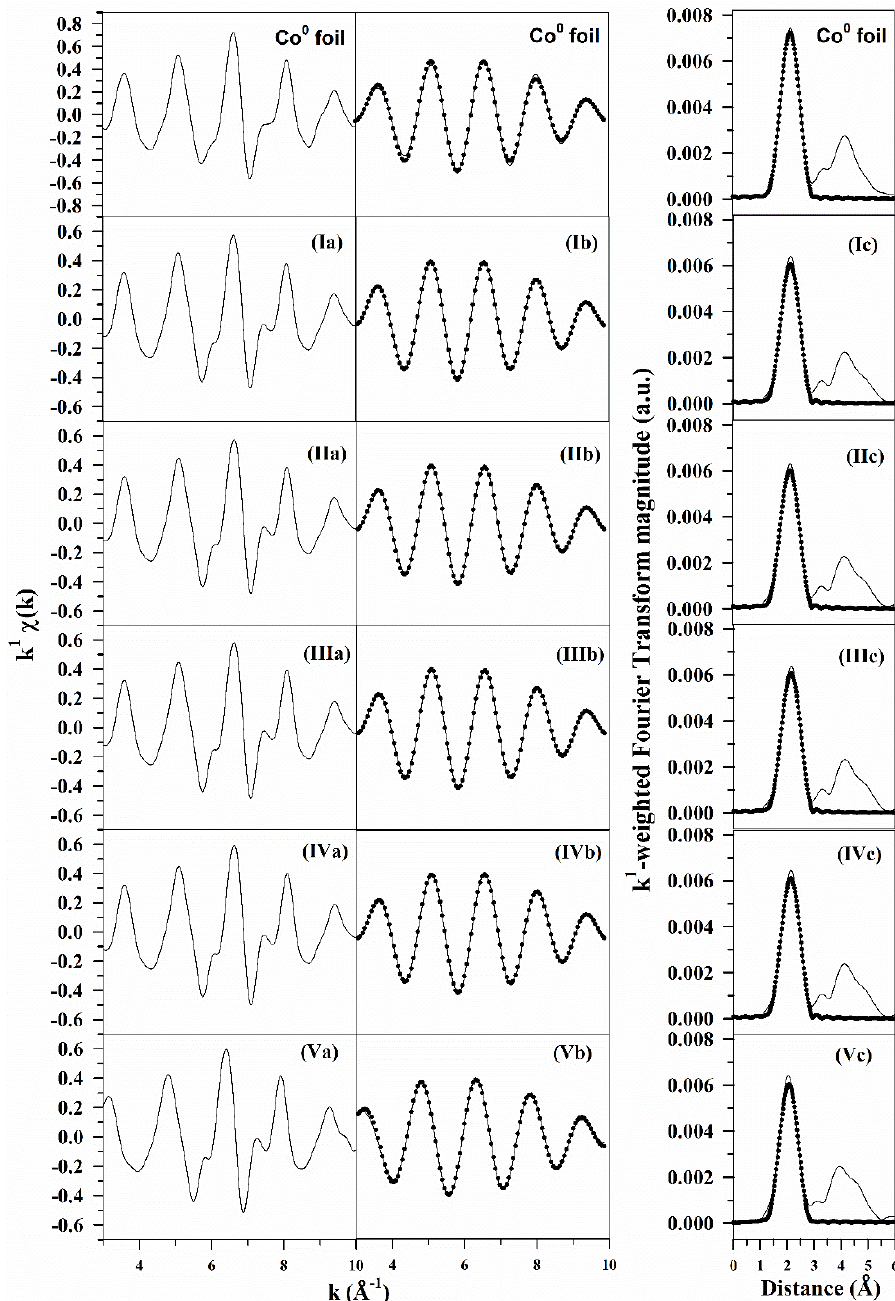
Figure 18. EXAFS fittings for Co K-edge data, including ( a ) raw k 1 -weighted χ (k) data; ( b ) (solid line) filtered k 1 -weighted χ (k) data and (filled circles) results of the fittings; ( c ) (solid line) raw k 1 -weighted Fourier transform magnitude and (solid line) filtered k 1 -weighted Fourier transform magnitude; and (filled circles) results of the fittings for Co 0 foil, ( I ) 25%Co / Al 2 O 3 , ( II ) 25%M (M = 5%Ni-95%Co) / Al 2 O 3 , ( III ) 25%M (M = 10%Ni-90%Co) / Al 2 O 3 , ( IV ) 25%M (M = 25%Ni-75%Co) / Al 2 O 3 , and ( V ) 25%M (M = 50%Ni-50%Co) / Al 2 O 3 .